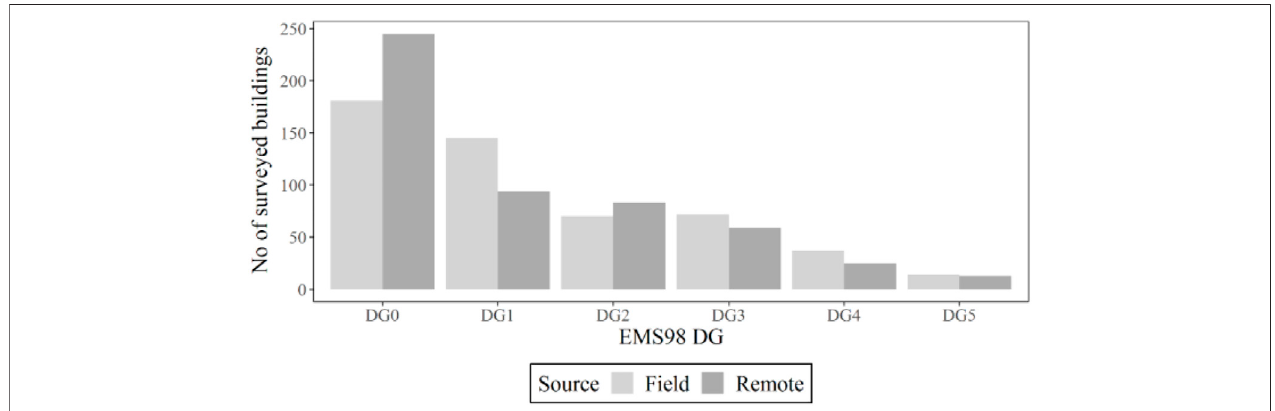
FIGURE 4 | Comparative damage levels from fi eld-assessment and remote- (or secondary-) assessment of fi eld data.